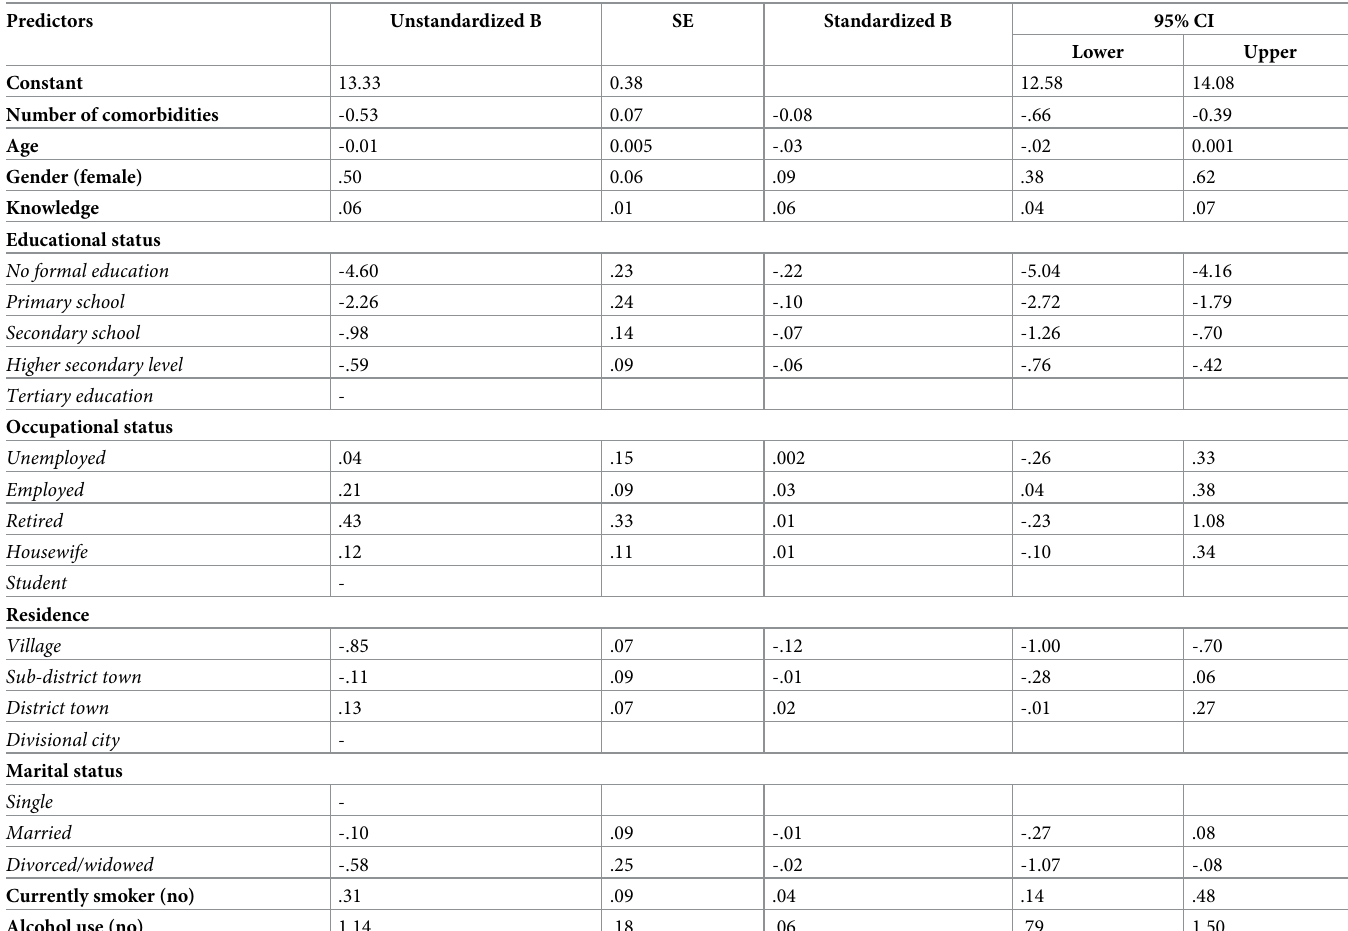
Table 2. Linear regression analysis of the variables associated with COVID-19 preventive